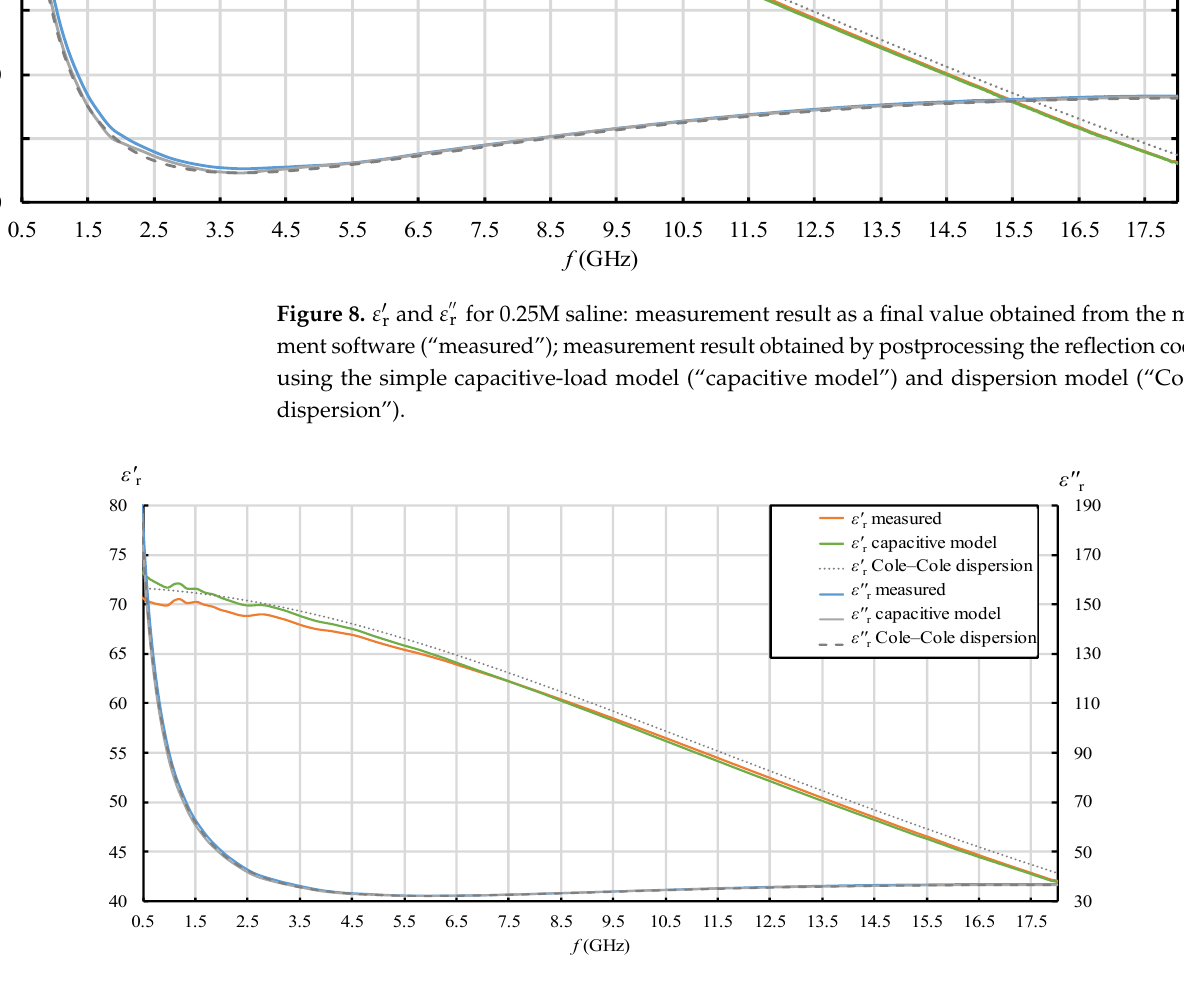
Figure 9. 𝜀 r′ and 𝜀 r″ for 0.5M saline: measurement result as a final value obtained from the meas- urement software (“measured”); measurement result obtained by postprocessing the reflection co- efficient using the simple capacitive- load model (“capacitive model”) and dispersion model (“Cole – Cole dispersion”).